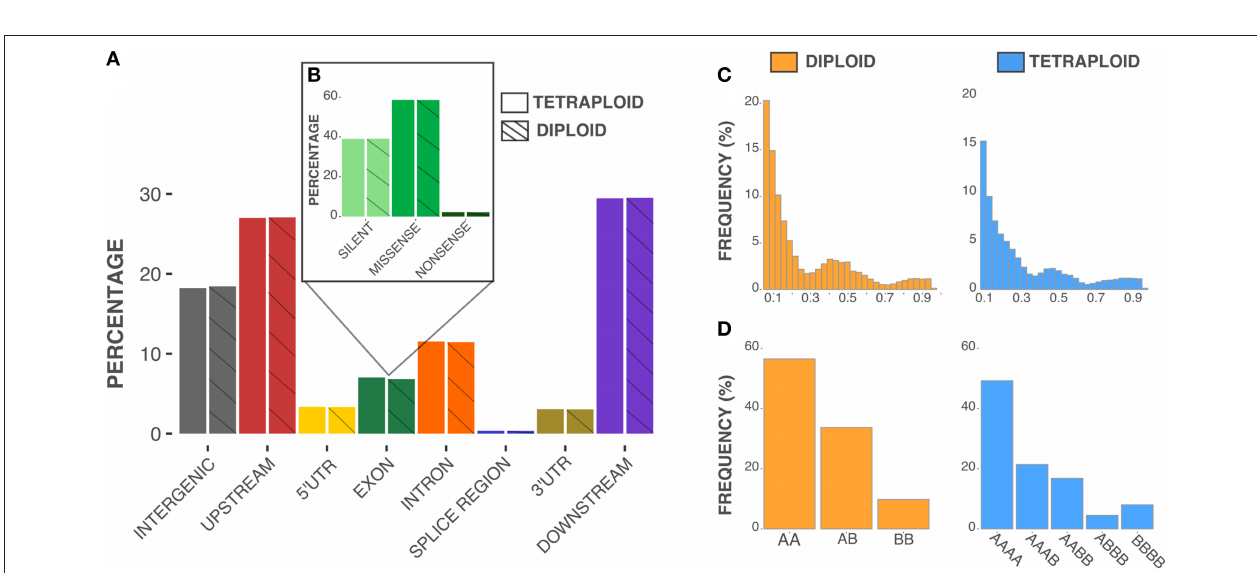
FIGURE 3 | Characterization of SNPs identified in diploid and tetraploid pipelines. (A) Percentage of SNPs located in distinct genomic regions. Upstream and downstream regions refer to distances less than 5kb from surrounding genes. (B) Functional effects of SNPs located in exonic regions. (C) Distribution of alternative (“B”) allele frequency. (D) Distribution of genotypic frequencies across loci.